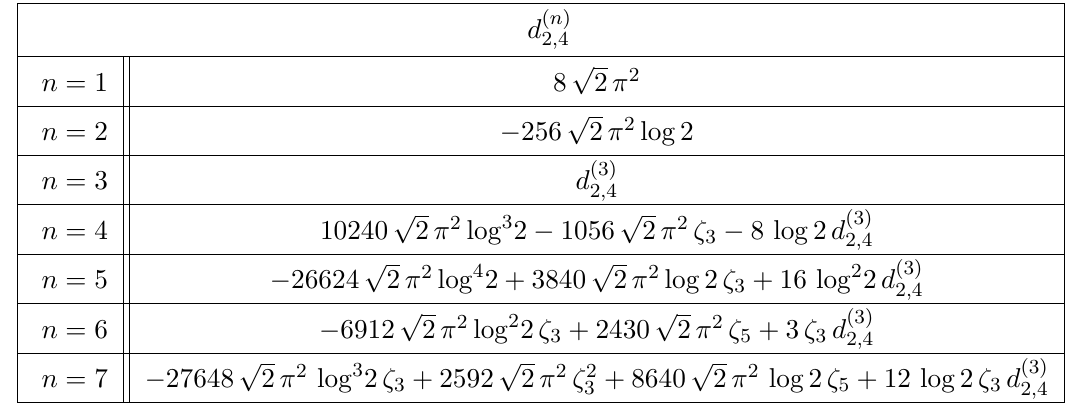
Table 1 . The first seven coefficients d ( n )